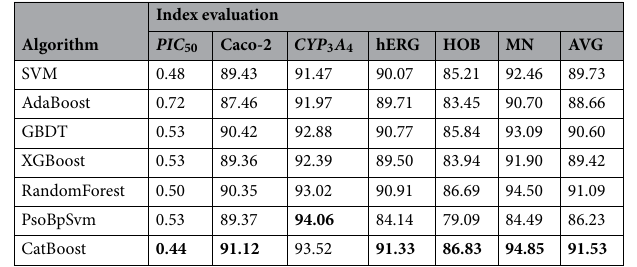
Table 3. Comparison of relation mapping models. AVG:ADMET property prediction average accuracy. Significant values are in [bold].